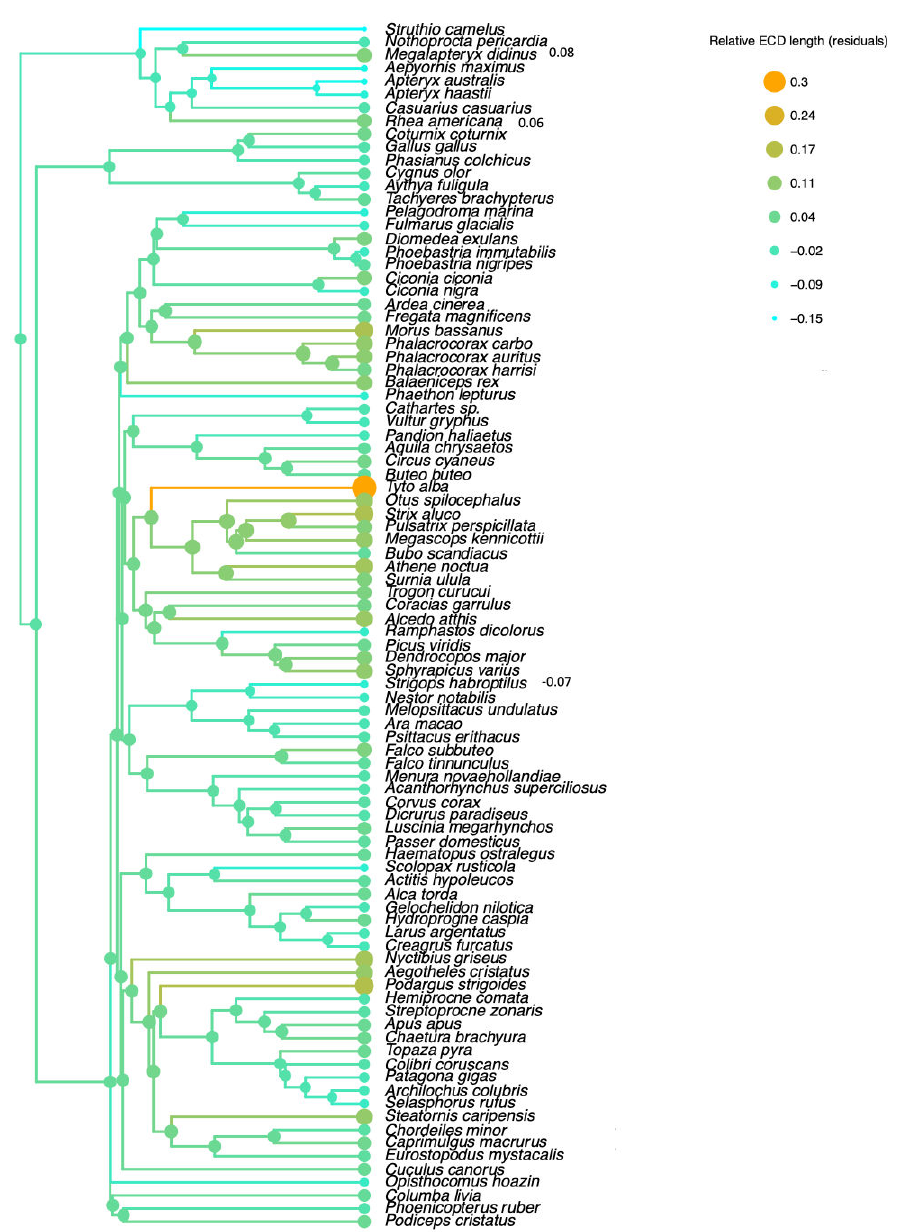
Figure 9. Endosseous cochlear duct residuals plotted to phylogeny (residual values added against taxa of